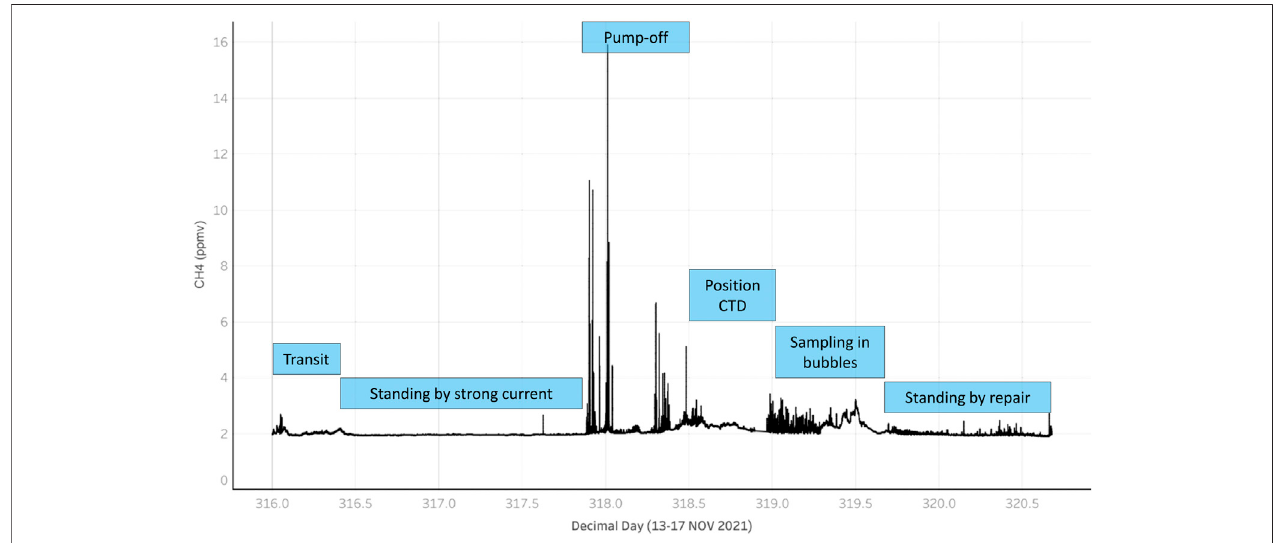
FIGURE 11 | Annotated timeline of CRDS measurements during the 2021 cruise of opportunity: major methane peaks con fi ned to periods when oil was pumped into storage tanks or released due to operations under the containment dome. Minor methane peaks observed with the ship stationary over the bubble stream.